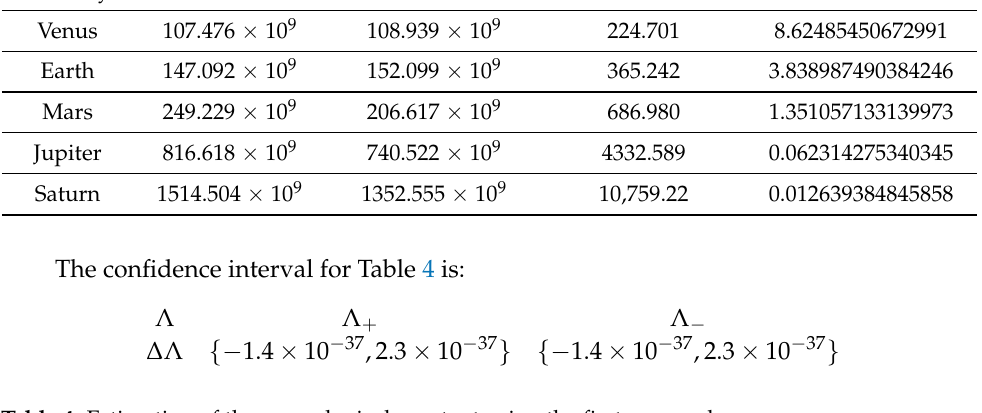
Table 3. Nasa data